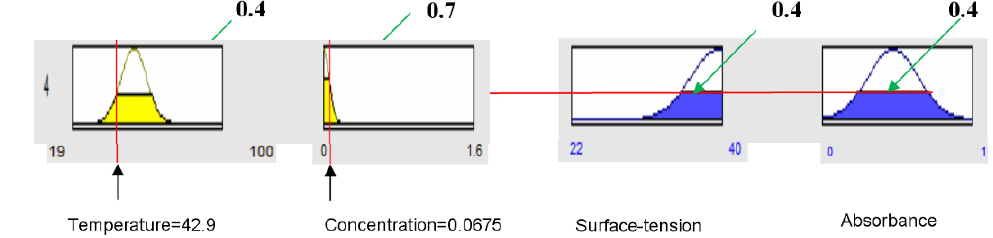
Figure 11. Fuzzy